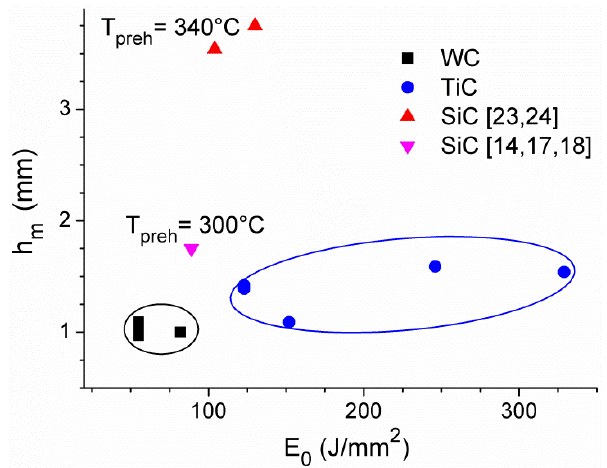
Figure 5. Parameters of the laser dispersing of carbide powders in Al-based substrates, results of this work and literature data shown as dependence of the melting depth h m vs. laser energy density E 0 , with assumed homogenous grain distribution; the MMC single trace width is at least 85% that of the laser spot in all cases except that of SiC powder dispersed in Al preheated to 300 °C (pink down-pointing triangle).